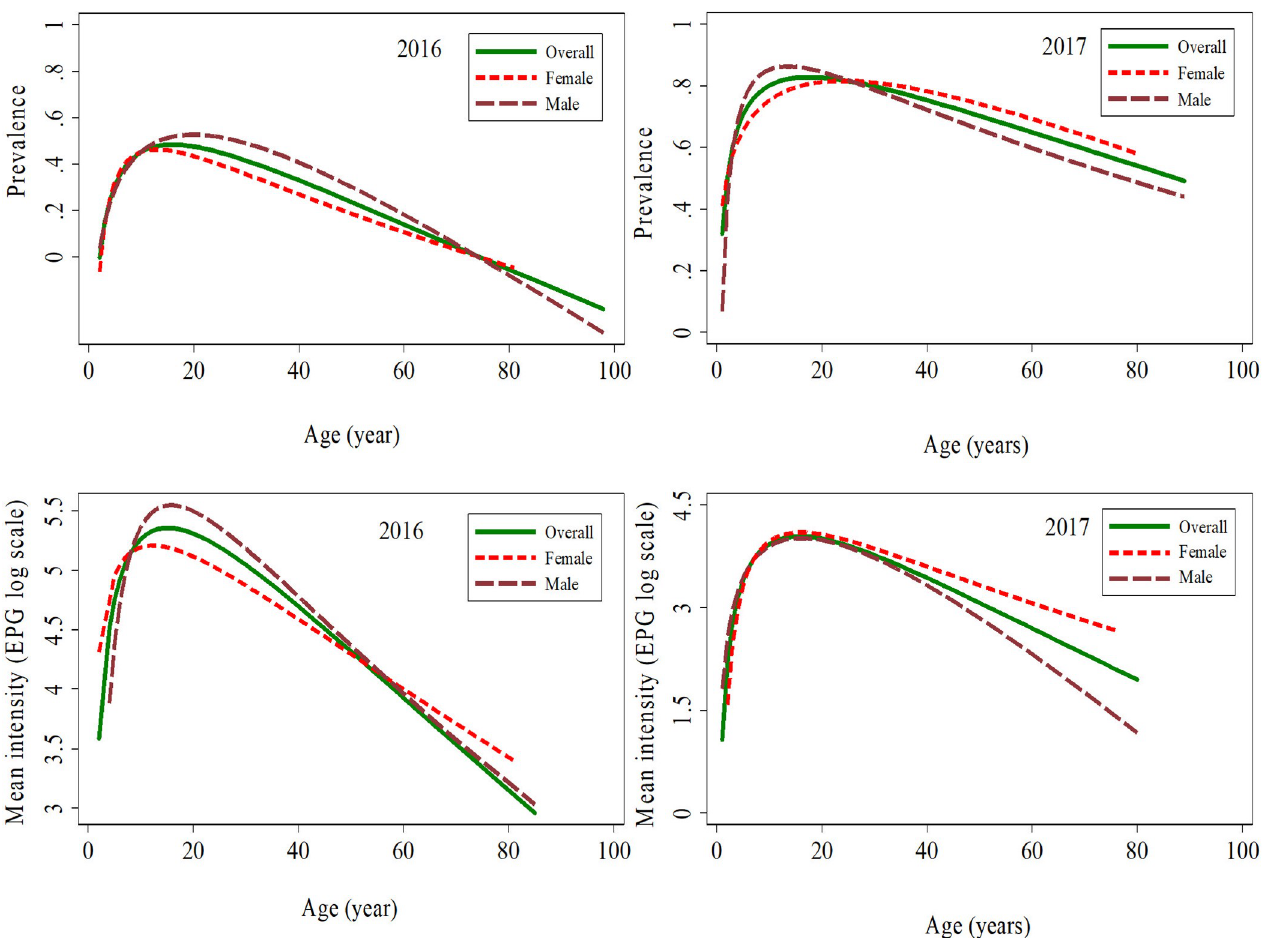
Fig 6. Schistosoma mansoni infection prevalence and intensity by age and sex in the two studies. Top: S . mansoni infection prevalence by age in 2016 and 2017. Bottom: S . mansoni infection intensity (log scale) by age in 2016 and 2017. Lines: Green (solid): all participants; Red (dashed): female; Maroon (long dashed):